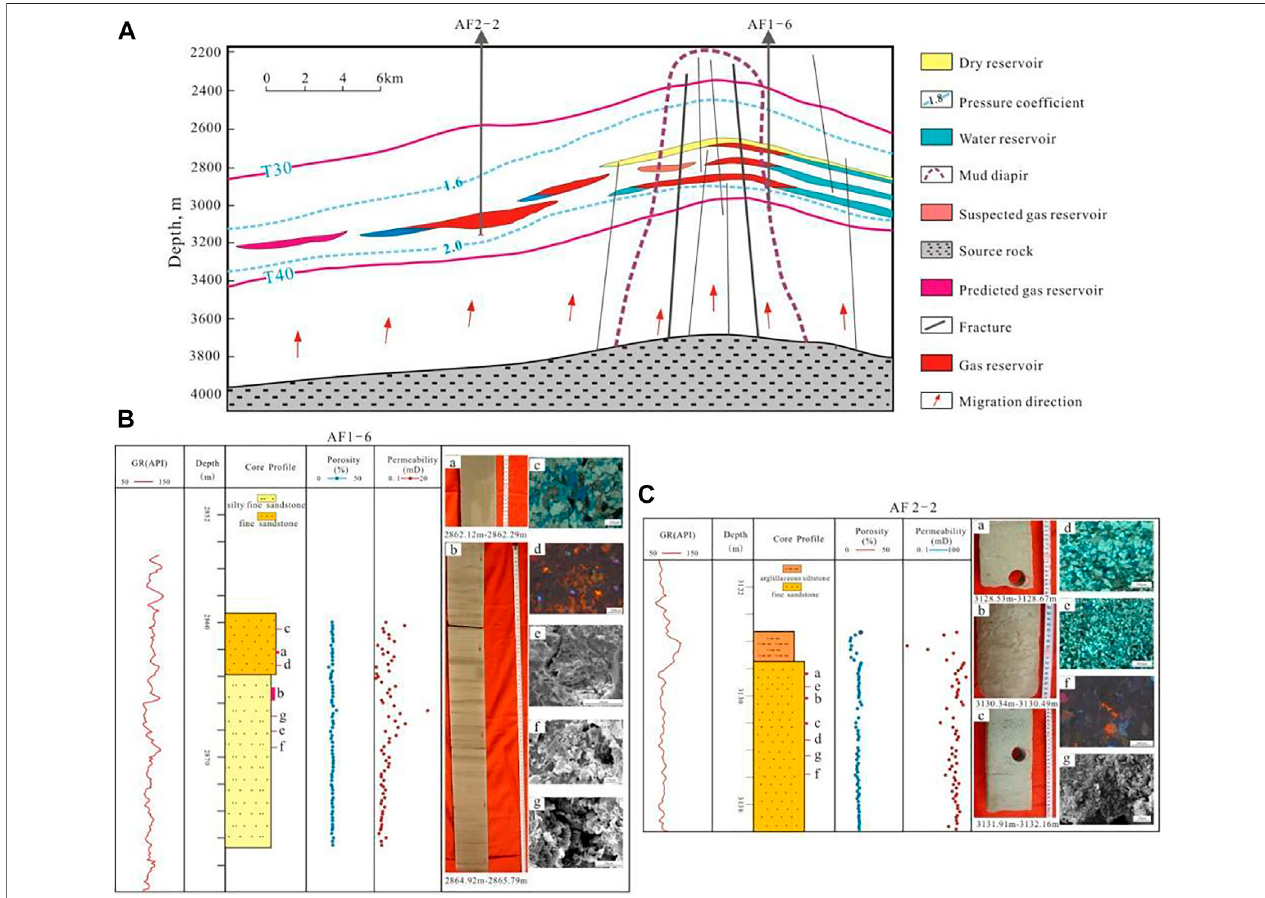
FIGURE2| AccumulationmodelofnaturalgasaccumulationrelatedtomuddiapirintheDongfangdistrictintheYinggehaiBasin (A) (modi fi edfromXieetal.,2012). The comprehensive pro fi le comprising logging characteristics, lithology, physicalproperties, and photographs ofcores and diagenetic alterations in well AF-1 – 6 (B) and well AF-2 – 2 (C) in the Dongfang